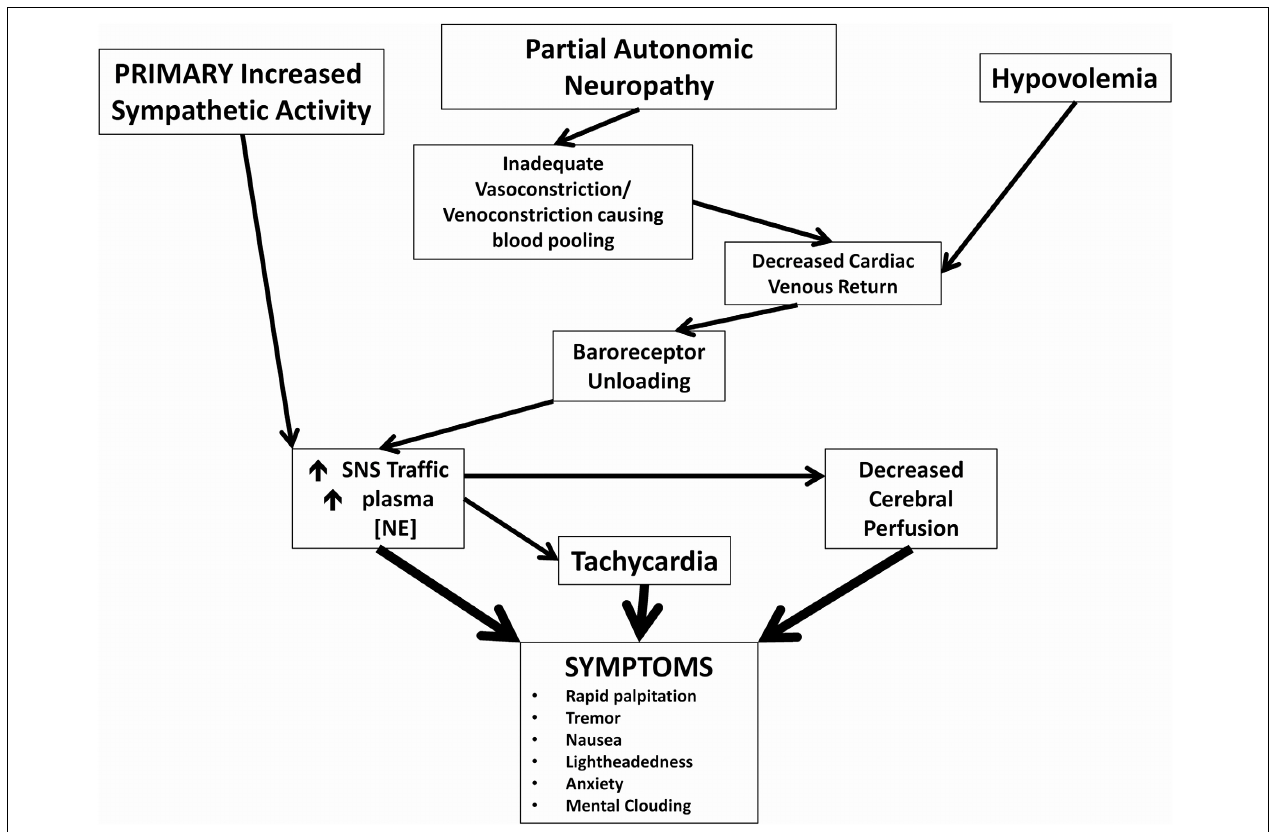
FIGURE 1 | Pathophysiological mechanisms of postural tachycardia syndrome. Cartoon representation of how 3 major neuronal and hormonal abnormalities and their immediate effects may cause symptoms commonly associated with